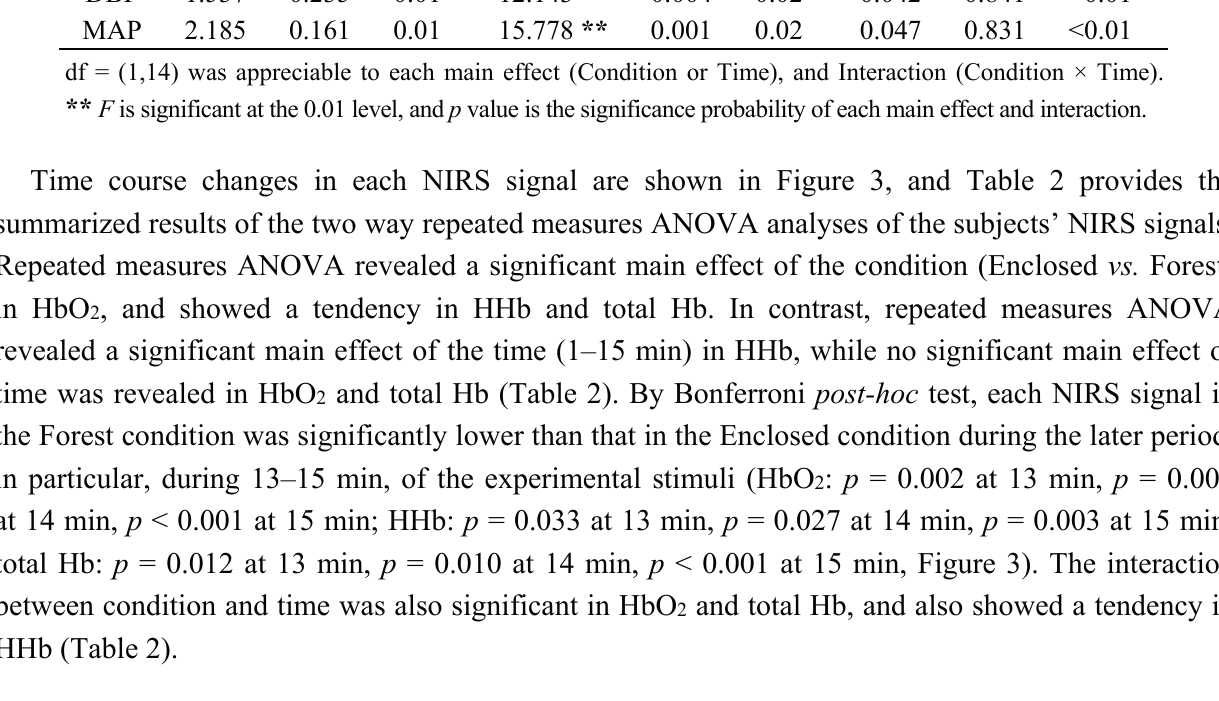
Table 1. Results of the two-way repeated measures ANOVA for the blood pressure (BP) variables. Main Effect Interaction Condition Time Condition × Time BP (Enclosed vs. Forest) (pre vs. post) F p η 2 F p η 2 F p η 2 SBP MAP 0.001 <0.01